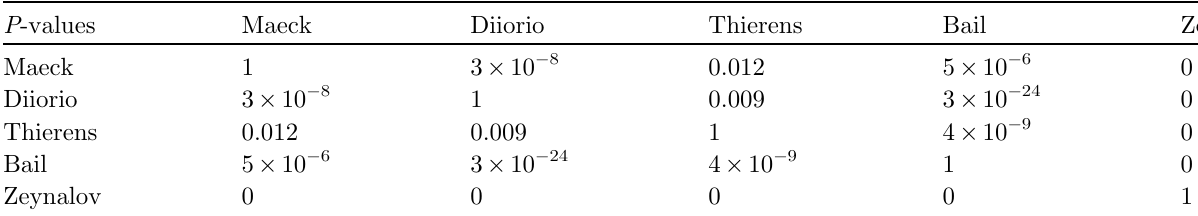
Table 1. P -value for fi ve sets of data. Results are presented according to a matrix since each set can be considered as a reference dataset. No bias appears when symmetrical P -value matrix is obtained. Only two sets are in agreement for a 99.5% con fi dence level (corresponding to a P -value greater than a quantile 1 – 0.995) if we consider Maeck set without the masses 135 and 136.